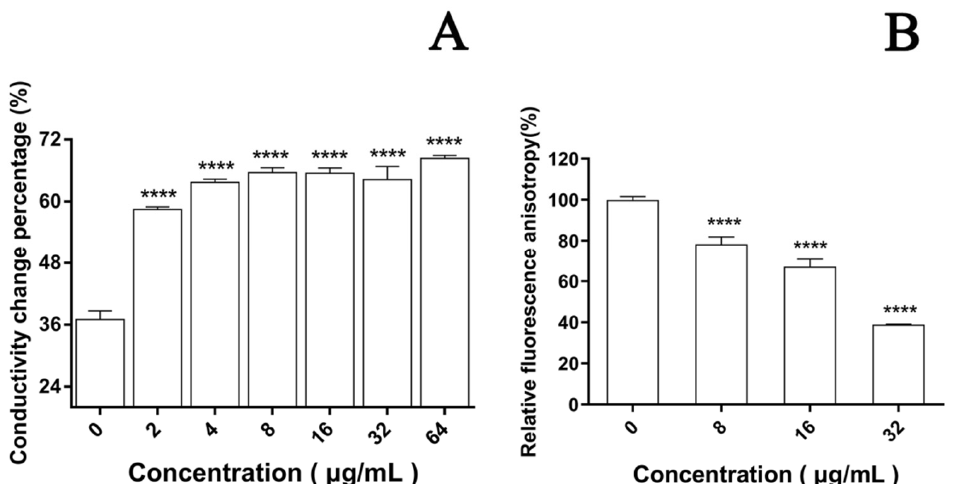
Figure 5. Effect of EA on cell membrane. ( A ) The effect of EA on the relative conductivity of the cell membrane of C. albicans . ( B ) The effect of EA on the cell membrane dynamic. Values are expressed as mean ± SD; n = 3; **** p < 0.0001 when compared to the control.